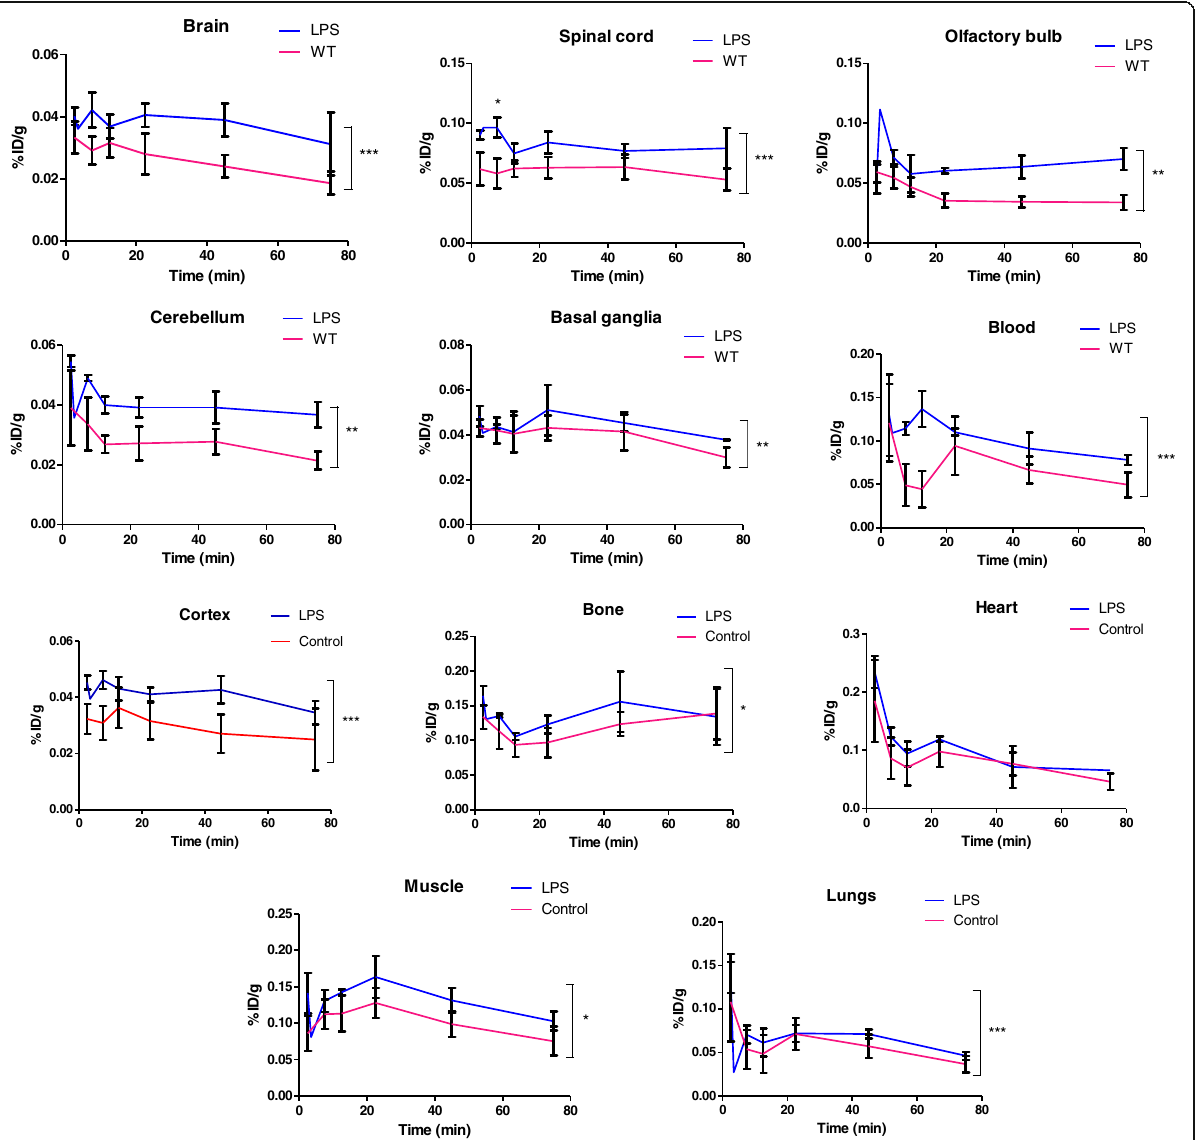
Fig. 8 In vivo %ID/g of [ 18 F]EFB in 24 h post-LPS injection and control rats ( n =3). Matched time and treatment variation significances representative of overall variations in the uptake are reported for each organ. Statistical analysis was carried out by a parametric two-way repeated measures ANOVA with column matching and with Bonferroni post-test. The asterisk indicates P <0.01; ** P <0.005; *** P